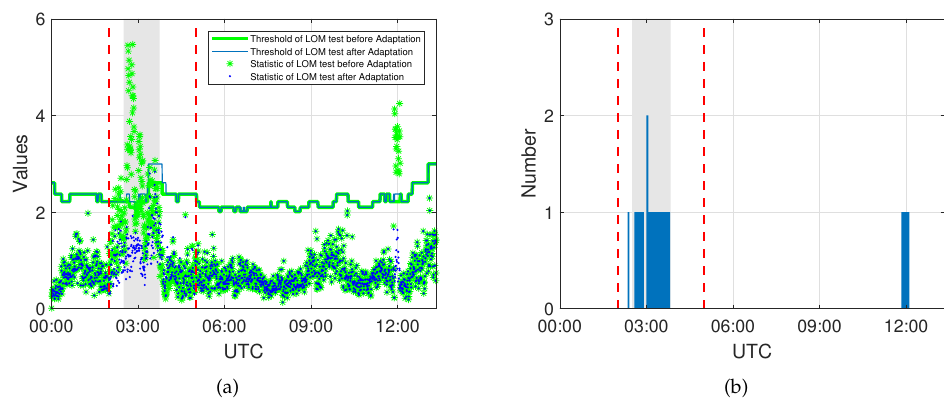
Figure 5. ( a ) Statistics of the Local Overall Model test with the threshold before and after adaptation and ( b ) the model errors identified at each epoch during Event 2.